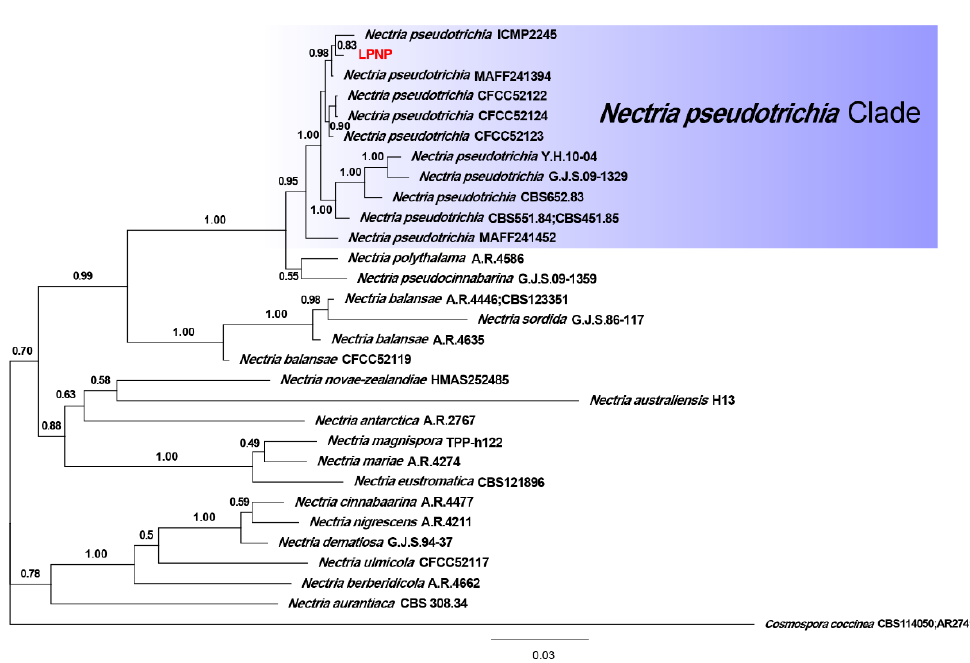
Figure 2. Morphological structures and cultural characteristics of Nectria pseudotrichia. ( a , b ) Upper and reverse sides of colonies on PDA, respectively; ( c ) upper side of colony on SNA; ( d ) conidial masses produced on PDA; ( e , f ) synnemata produced on PDA and SNA, respectively.